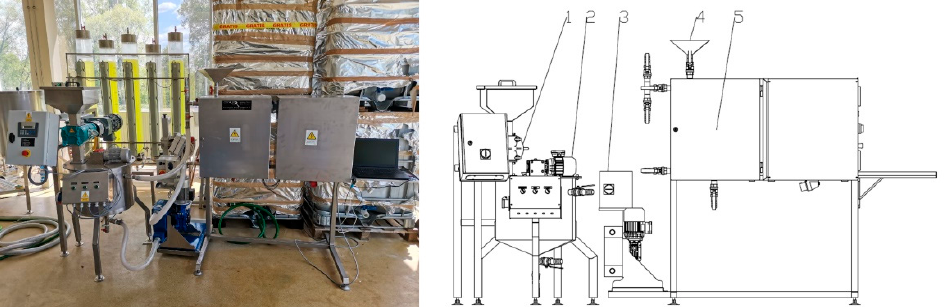
Figure 3. PEF disintegrator: (1) substrate shredder, (2) substrate tank with an agitator, (3) substrate pump, (4) charging hopper, and (5) disintegration chamber cabinet.